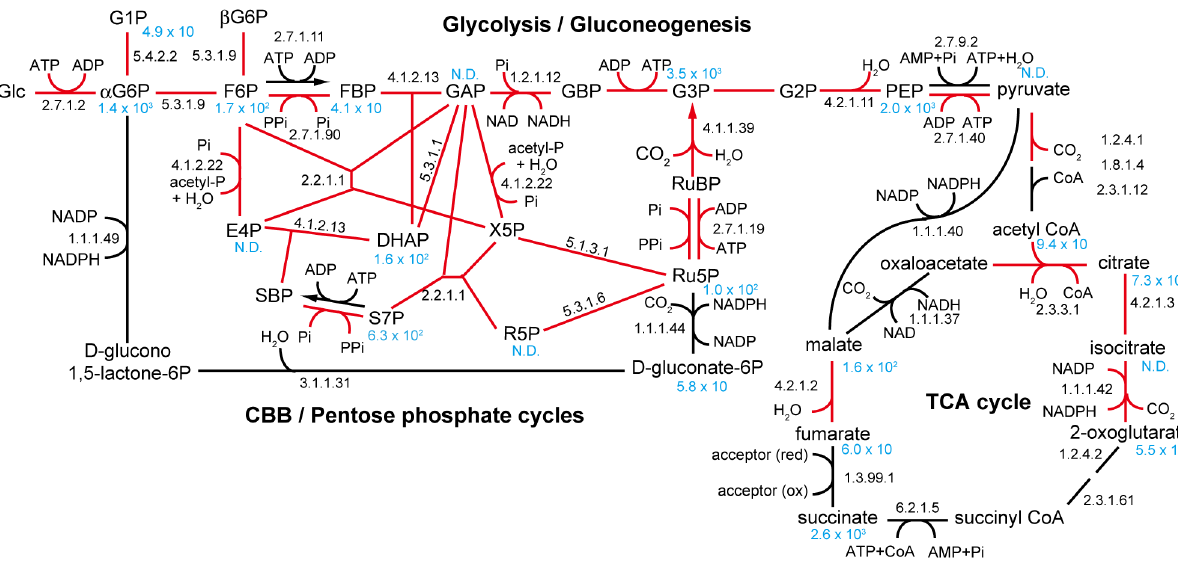
Figure 3. Predicted central metabolism of strain Hiromi 1. Red lines indicate conserved pathways in most of the publically accessible genomes of the chemolithoautotrophic Gammaproteobacteria . EC numbers are given on each enzymatic reaction. Light blue font indicates concentrations (per pmol 10 10 cells) of metabolites. Metabolites that were not targets of the metabolomic analysis were given neither concentrations nor N.D. N.D.; not detected. Pi, phosphate; PPi, pyrophosphate; Glc, a -D-glucose; a G6P, a -D-glucose-6-phosphate; G1P, a -D-glucose-1-phosphate; b G6P, b -D-glucose-1-phosphate; F6P, b -D-fructose-6-phophate; FBP, b -D-fructose-1,6-bisphosphate; GAP, glyceraldehyde-3-phosphate; GBP, glycerate-1,3-bisphosphate; G3P, glycerate-3-phosphate; G2P, glycerate-2-phosphate; PEP, phosphoenolpyruvate; E4P, erythrose-4-phosphate; acetyl-P, acetyl phosphate; DHAP, dihydroxyacetone phosphate; X5P, D-xylulose-5-phosphate; SBP, D-sedoheptulose-1,7-bisphosphate; S7P, D- sedoheptulose-7-phosphate; RuBP, ribulose-1,5-bisphosphate; Ru5P, ribulose-5-phophate; R5P, D-ribose-5-phosphate.